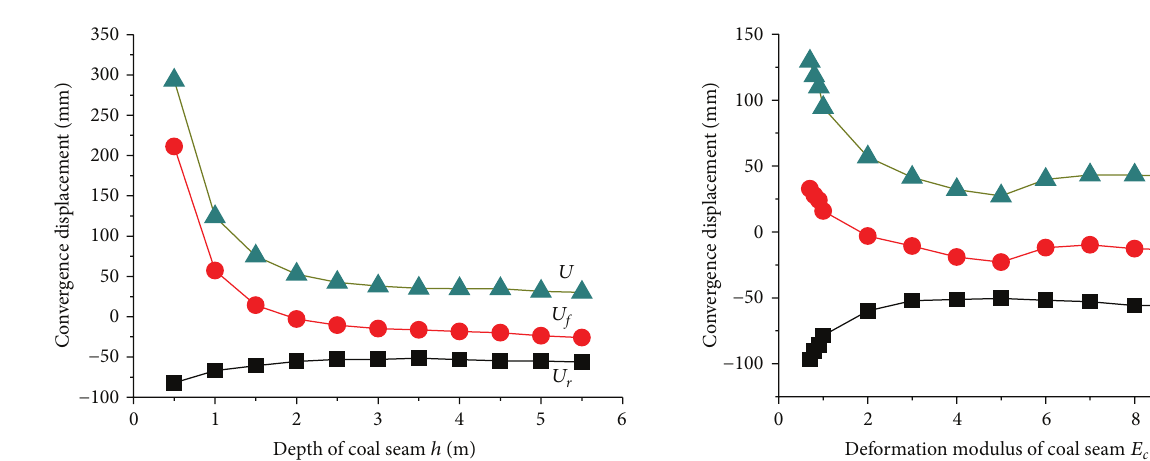
Figure 7: Changes of tunnel displacements with deformation modulus of coal seam.